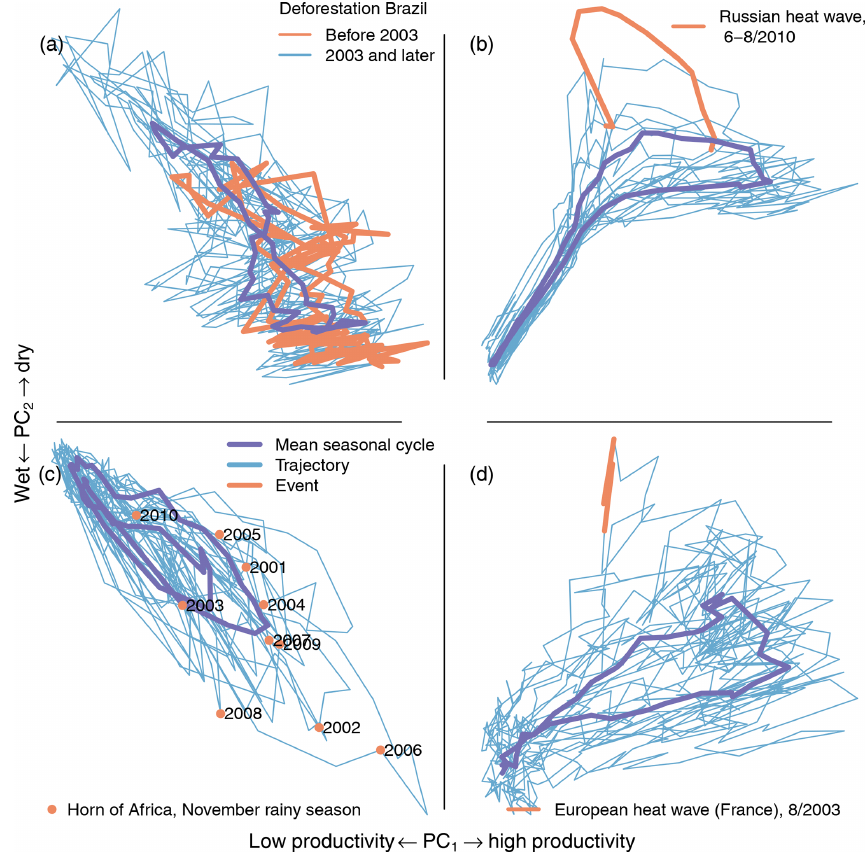
Figure 9. Trajectories of the first two principal components for single pixels. (a) Deforestation increases the seasonal amplitude of the first two PCs (Brazilian rain forest, 9.5 ◦ S, 63.5 ◦ W). The red line shows the trajectory before 2003 and the blue line the trajectory 2003 and later. A strong increase in seasonal amplitude can be observed after 2003. (b) The heat wave is clearly visible in the trajectory (red, Russian heat wave, summer 2010, 56 ◦ N, 45.5 ◦ E). (c) Rainfall in the short rainy season (November–December) influences agricultural yield and can cause flooding (extreme flooding after drought, November 2006, 3 ◦ N, 45.5 ◦ E). (d) The European heat wave in summer 2003 was one of the strongest on record (France, 47.2 ◦ N, 3.8 ◦ E). The mean seasonal cycle of the trajectories is shown in